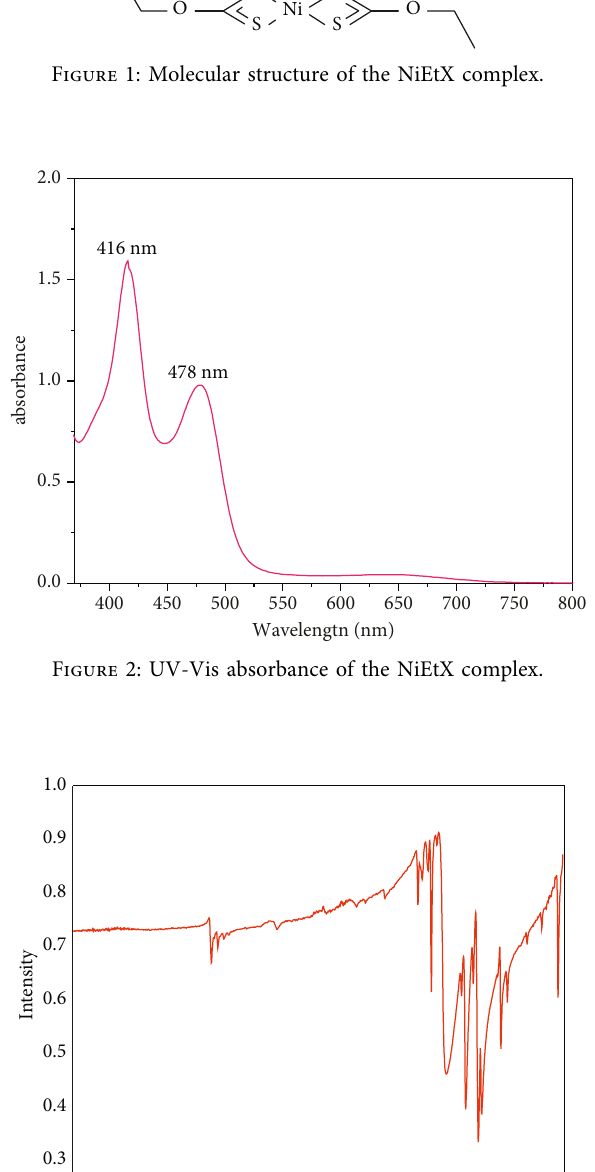
Figure 1: Molecular structure of the NiEtX complex.